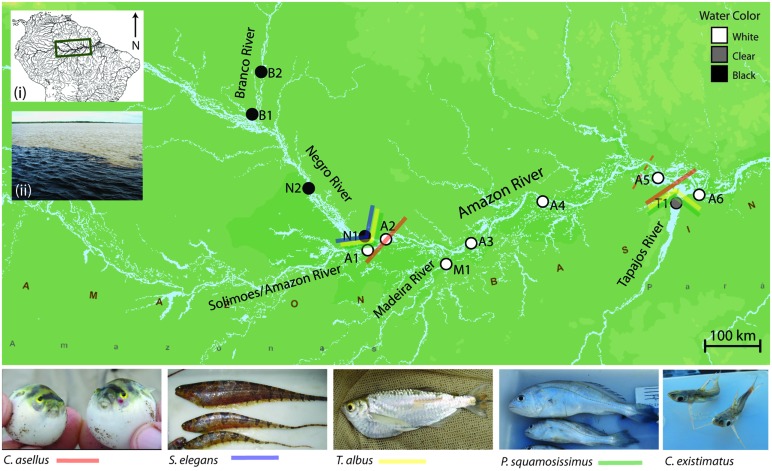
Map showing sampling sites and major population boundaries identified for each of the five study species (excluding C. existimatus). Analyses used either a combination, or all of the following analytical methods based on nDNA and mtDNA sequences and on AFLP markers: nested clade phylogeographic analysis (Templeton et al., 1987), STRUCTURE (Falush et al., 2003), mtDNA ΦST (Excoffier et al., 1992), and AFLP FST (Lynch and Milligan, 1994). Site abbreviations are: N, Negro River; B, Branco River; A, Amazon River; M, Madeira River; T, Tapajós River.